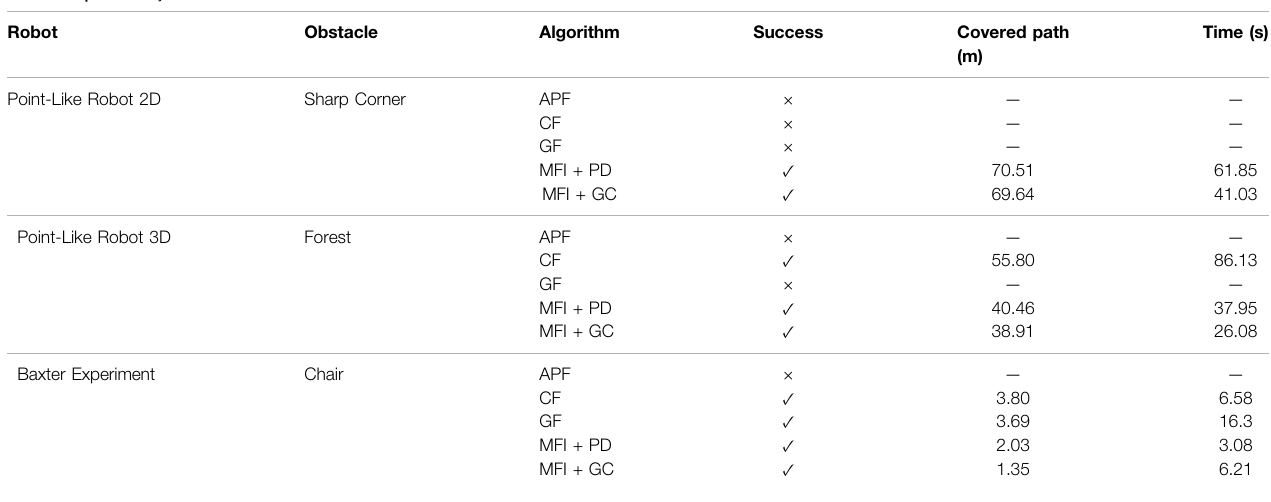
TABLE 2 | Summary of